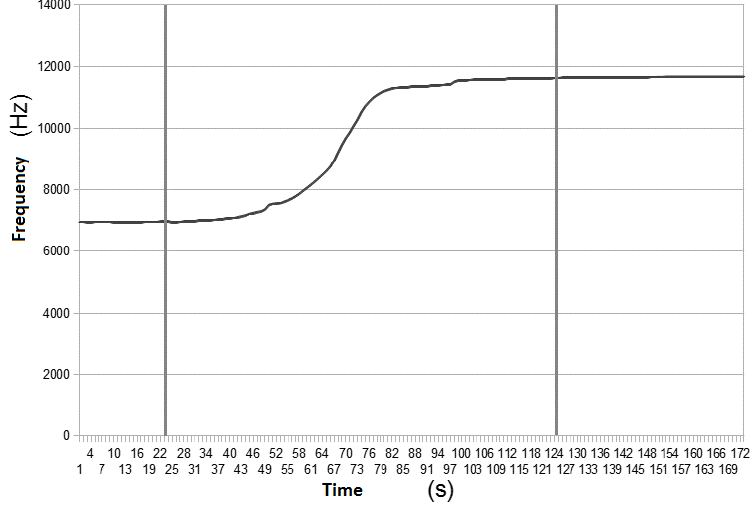
Figure 13. Laboratory tests results.